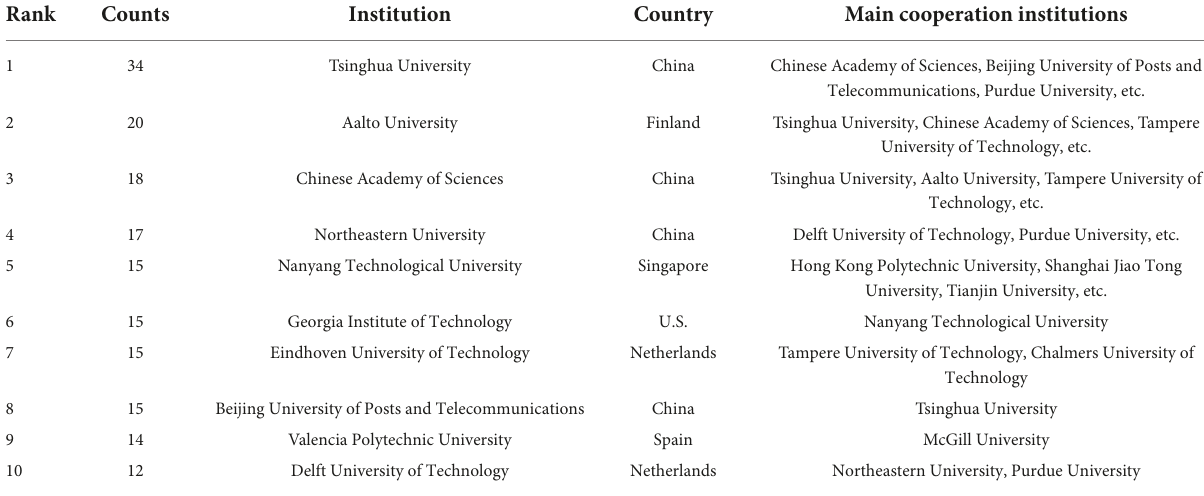
TABLE 1 Cooperation analysis of the top 10 core institutions. Rank